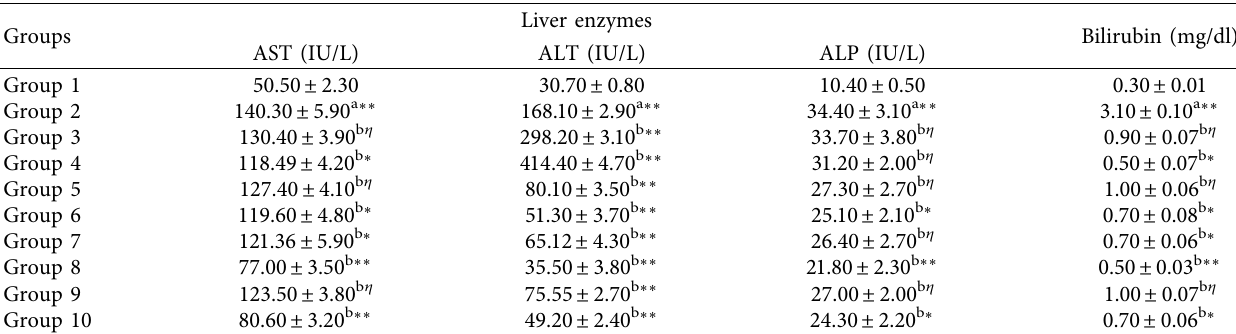
Table 5: Effect of polyherbal hepatoprotective formulations on biochemical serum parameters in CCl